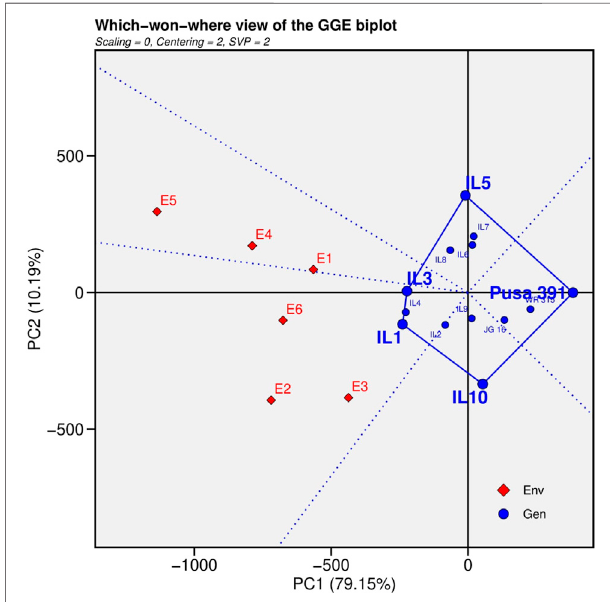
FIGURE 3 | “ Which-won-where ” view for the primary component of interaction (PC1) and second principal component (PC